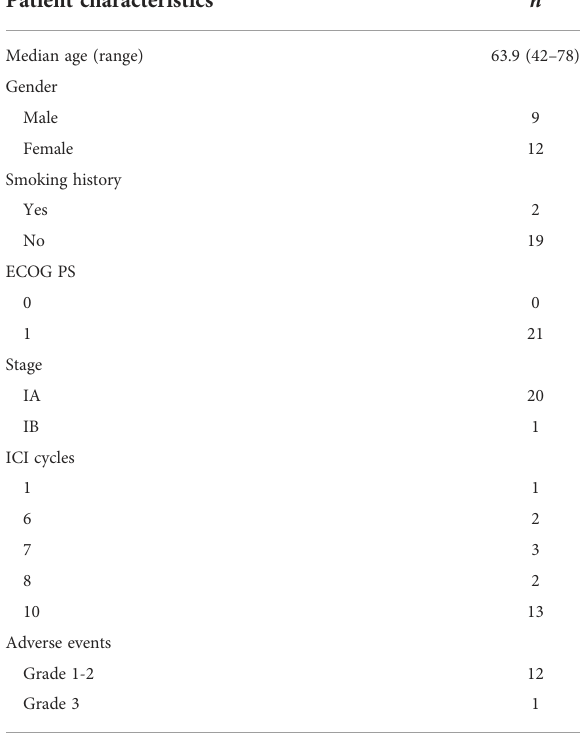
TABLE 1 Patient characteristics and treatment